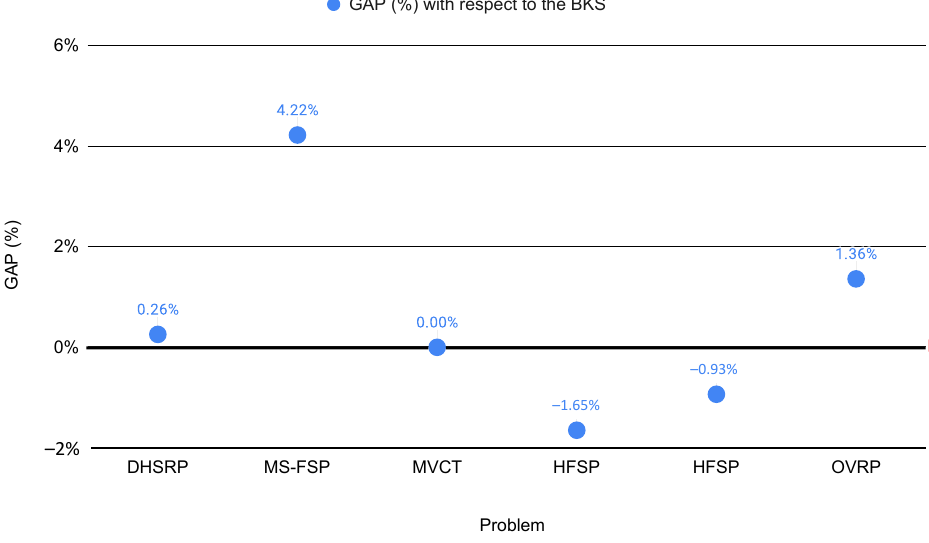
Figure 8. Gaps between OBS and BKS (baseline 0%